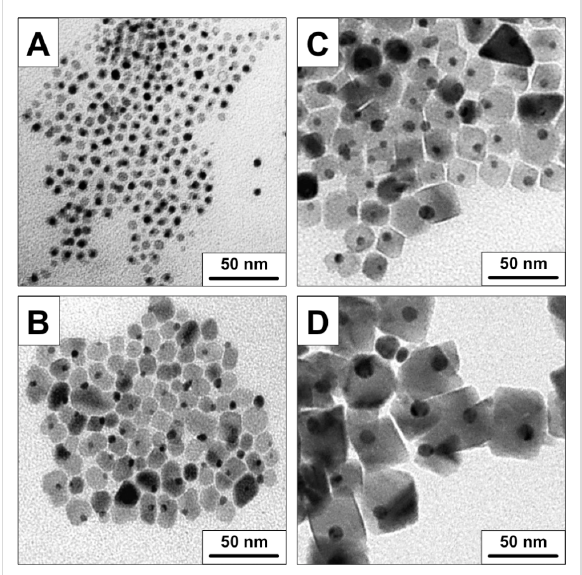
Figure 1: Bright-field TEM images of size-selected magnetite–gold NPs with in situ synthesized Au seeds: A) MNP-6; B) MNP-15; and with presynthesized Au seeds: C) MNP-25; D) MNP-44. The sample numbers reflect the Fe 3 O 4 NP mean size in nanometers.